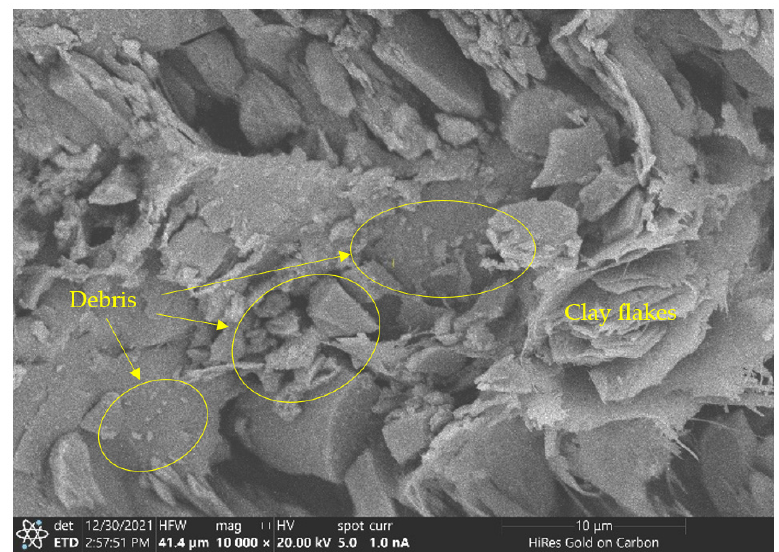
Figure 5. SEM photo of sample 2.